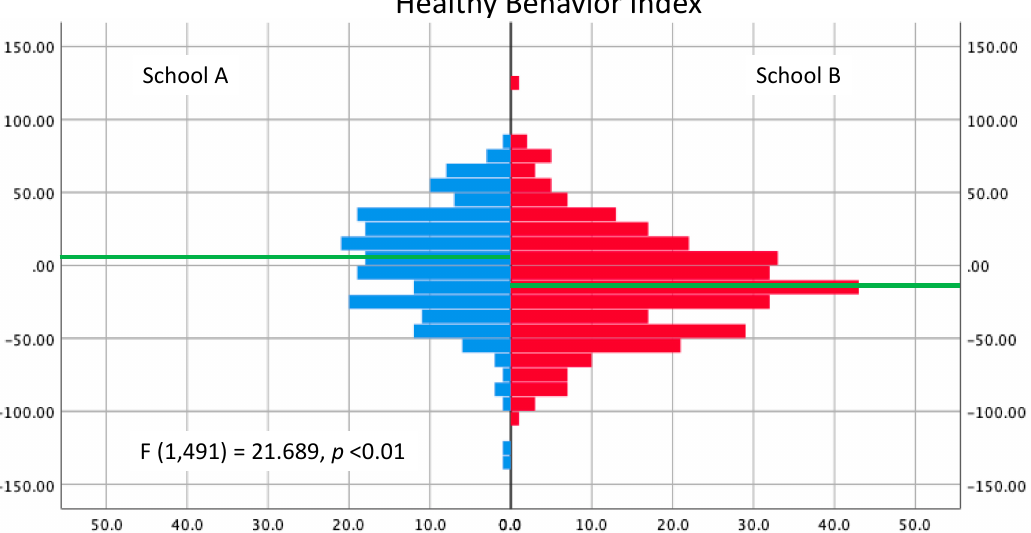
Figure 2. Distribution of the healthy behavior index (HBI) scores for School A and School B, with the horizontal green line approximating the mean difference in each school.